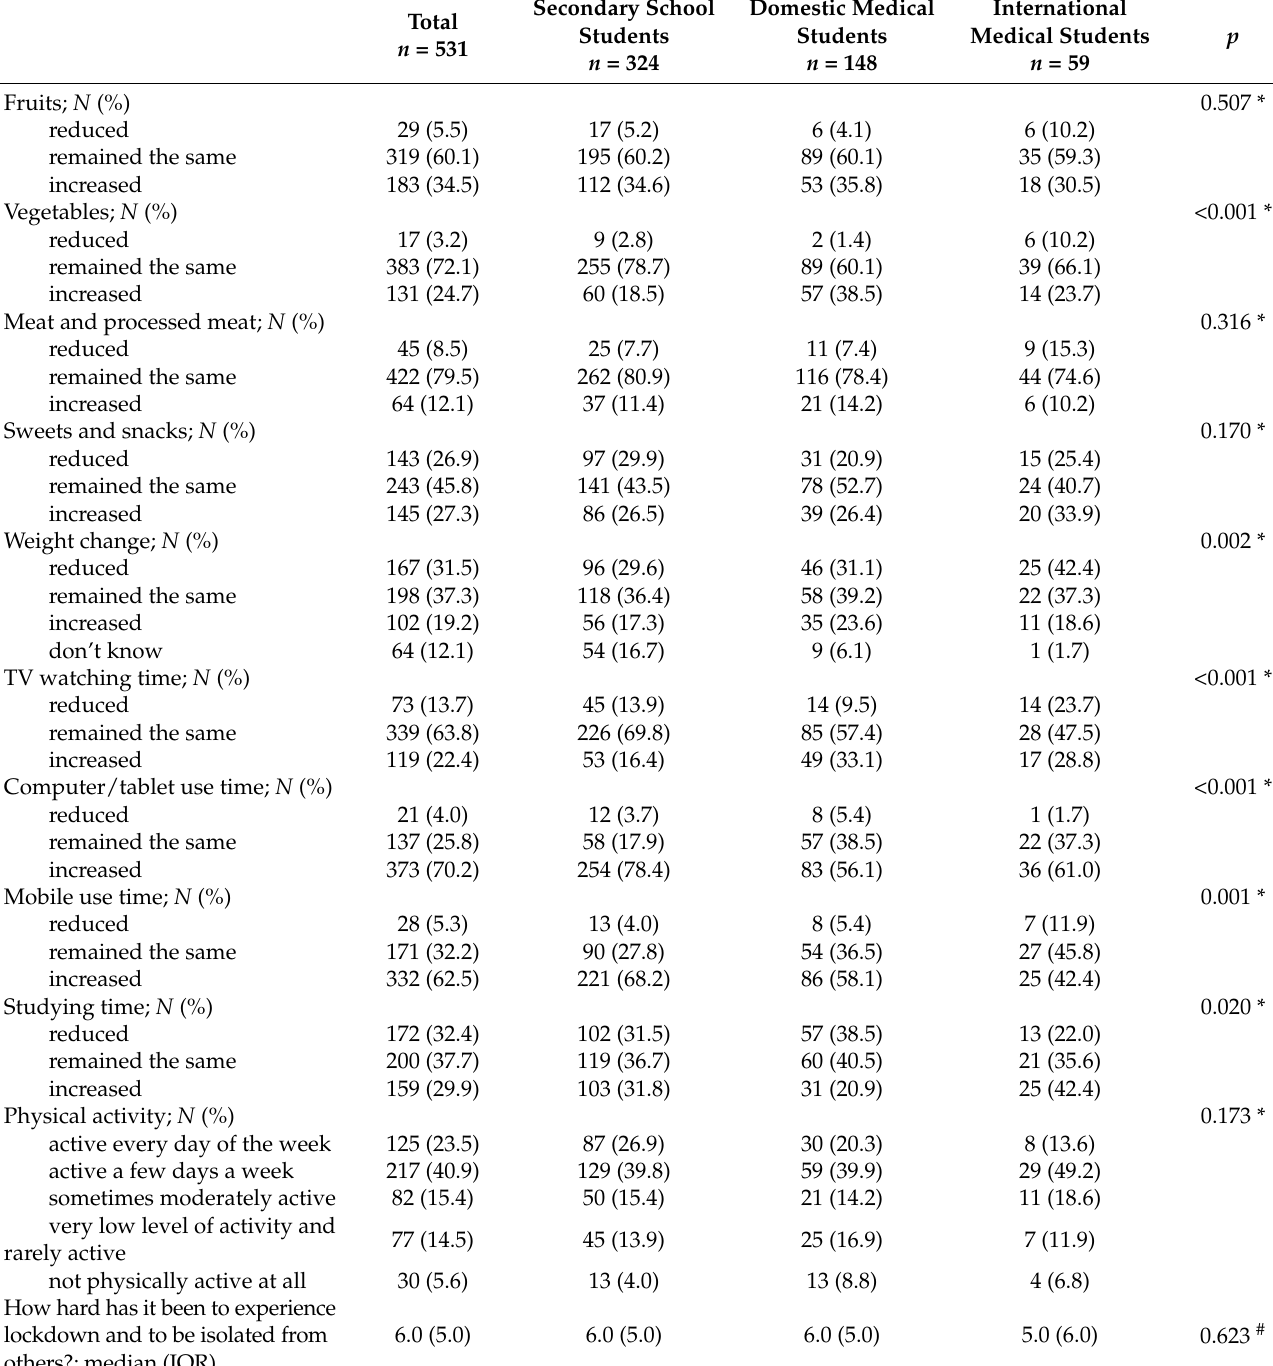
Table 3. Self-perceived habits change in students during COVID-19